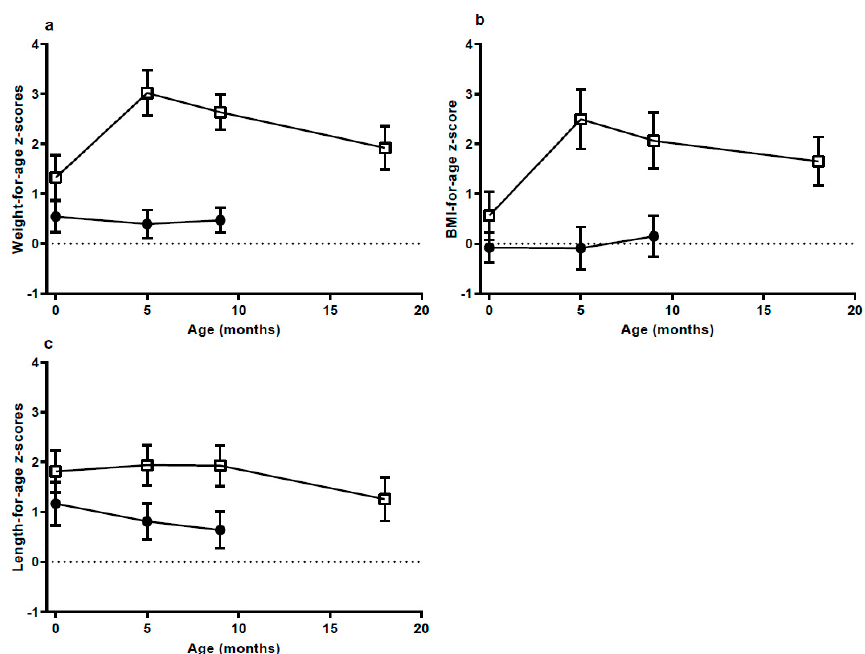
Figure 1. ( a ) Weight-for-age; ( b ) body mass index (BMI)-for-age and ( c ) length-for-age z -scores, according to groups presented as mean and 95% confidence interval at birth (High weight gain group (HW) n = 13; Normal weight gain group (NW) n = 17), 5 months (mo) (HW n = 13; NW n = 17), 9 mo (HW n = 13; NW n = 17) and 18 mo (HW n = 12 (weight and length for two infants were self-reported)). Data at 18 mo were not available for the NW group. HW = □ NW = ● .